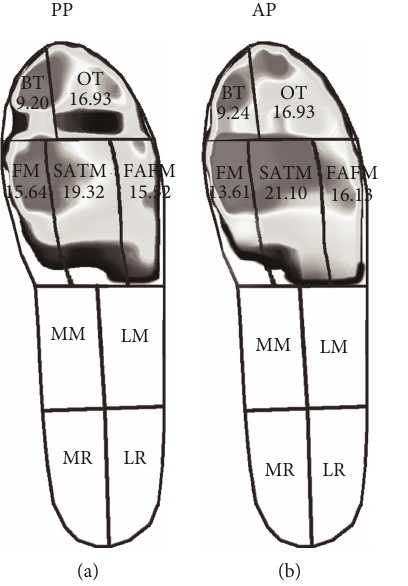
Figure 2: The contact area of the PP (a) and AP (b). Unit: cm 2 .